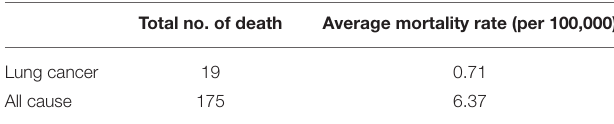
TABLE 3 | PM 2.5 related premature deaths attributable to emissions in December